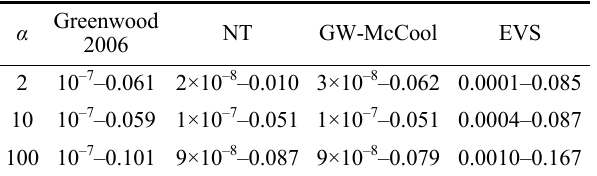
Table 3 The real area of contact to the nominal area when the distance between two surfaces is